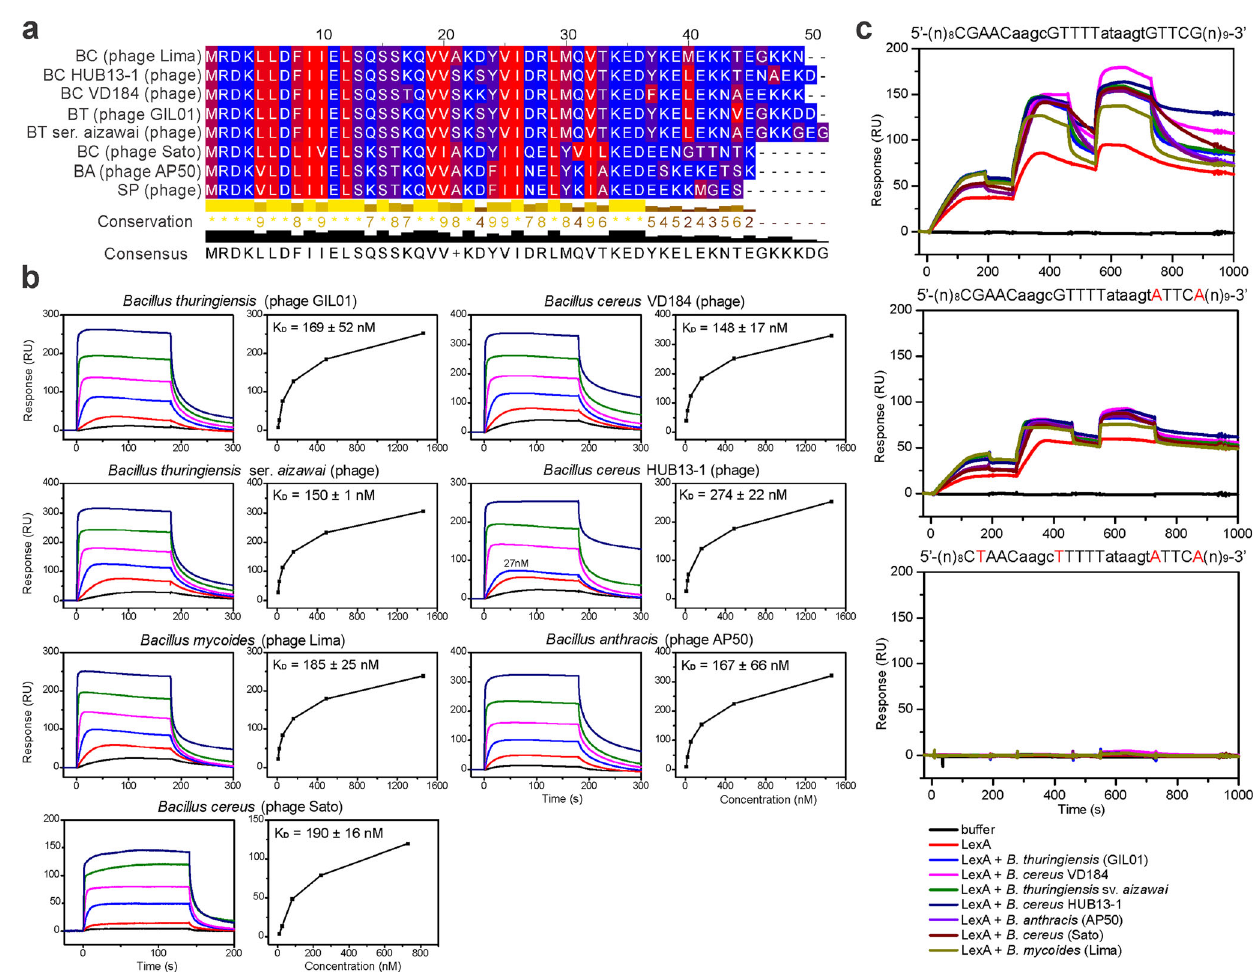
Fig. 4 Tectiviral gp7 homologs interact with and enhance the DNA-binding properties of B. thuringiensis LexA. a Amino-acid sequences of tectiviral gp7 homologs aligned with Clustal Omega and visualized using Jalview. Amino acids are color coded according to the hydrophobicity scale, with red indicating hydrophobic residues, and blue indicating hydrophilic residues. b Surface plasmon resonance sensorgrams of the interaction of gp7 and gp7 homologs (respective hosts are indicated above the diagrams) with immobilized B. thuringiensis LexA. Analytes were injected at 3-fold serial dilutions (6 – 1458 nM) for 180 s at a fl ow rate of 30 μ L min − 1 over chip-immobilized LexA. Apparent equilibrium dissociation constants (K D ) are expressed as means ± standard deviations of two titrations of each analyte. c Surface plasmon resonance sensorgrams of the interaction between B. thuringiensis LexA alone or pre- incubated with gp7 or gp7 homologs with the wild-type or mutant LexA operators from the GIL01 P1 promoter region 16 . Sequences of DNA fragments used are shown above the diagrams, with important nucleotides for LexA binding shown in capital letters, and changed nucleotides shown in red. Free LexA (5, 10, 20 nM) or LexA (5, 10, 20 nM) pre-incubated with gp7 and gp7-like proteins in 1:10 molar ratio (50, 100, 200 nM) were injected over the selected DNAs immobilized on the chip at 50 μ L min − 1 in a single cycle. The experiment was performed in duplicate and representative sensorgrams are